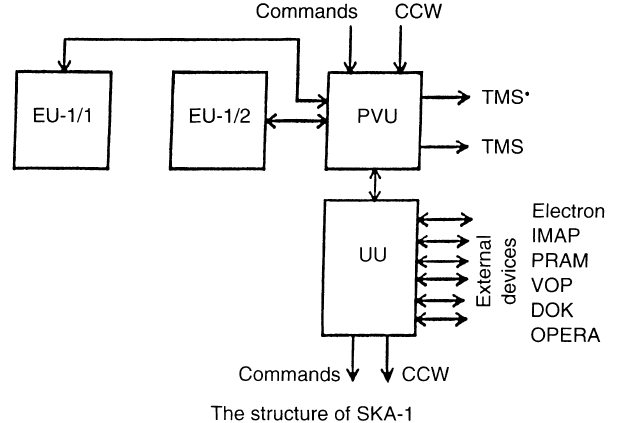
Fig. 1. The structure of SCA-1. It consists of two 2 (cid:112) sensor heads EU- 1/1 and EU-1/2, an onboard computer PVU, and controlling device UU-1